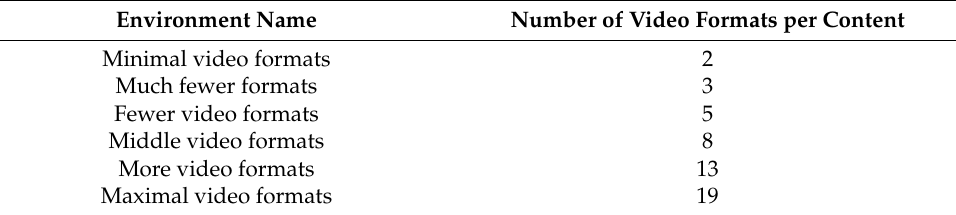
Table 5. Table of the environment